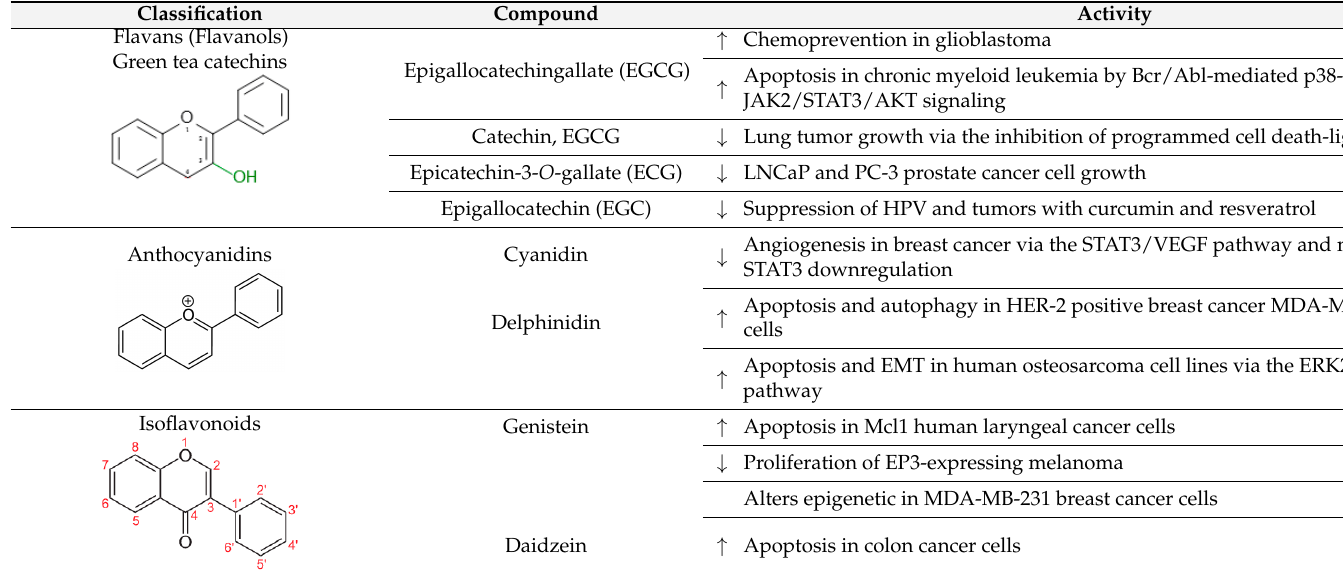
Dow arrows = inhibition; Top arrows: activation and/or promotion. Red colours in chemical formulas indicate the typical functional groups and/or chemical positions for typical attachments of substituents (isoflavonoids).